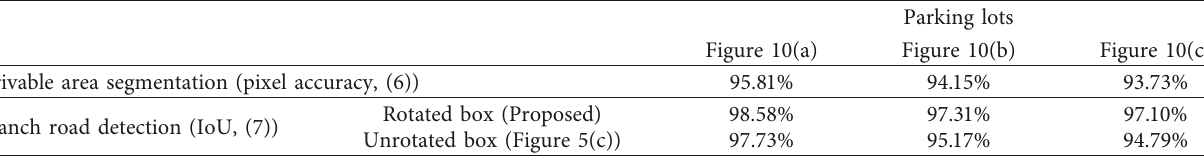
Figure 11: Results for intersection scan model (ISM) method. Table 1: Results of the perception